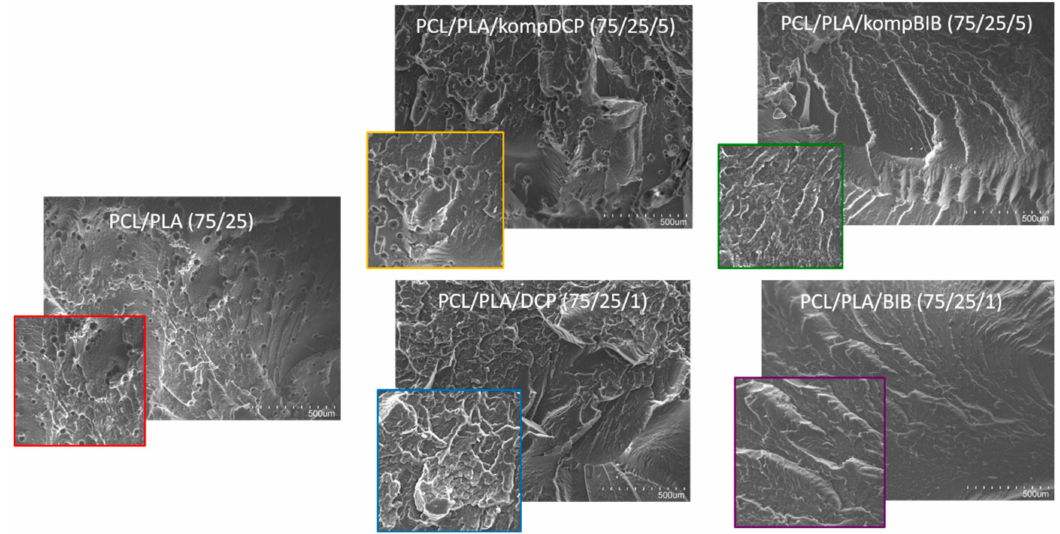
Figure 3. SEM images of PCL / PLA blend (75 / 25), and PCL / PLA blends compatibilized by copolymers and DCP or BIB in reactive